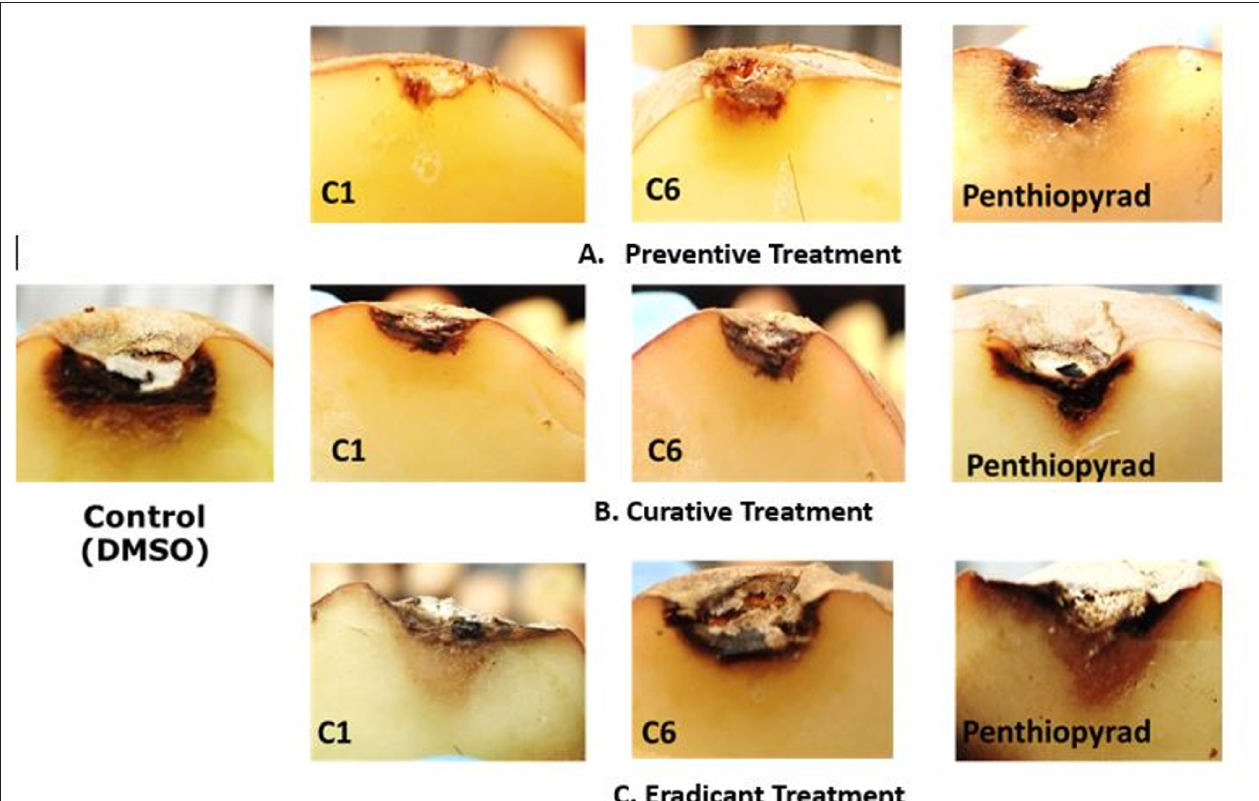
FIGURE 6 | Symptoms of A. solani infection on inoculated potato tuber treated with C1 and C6 at 21 dpi (A) Preventive treatment (B) Curative treatment (C) Eradicant treatment.